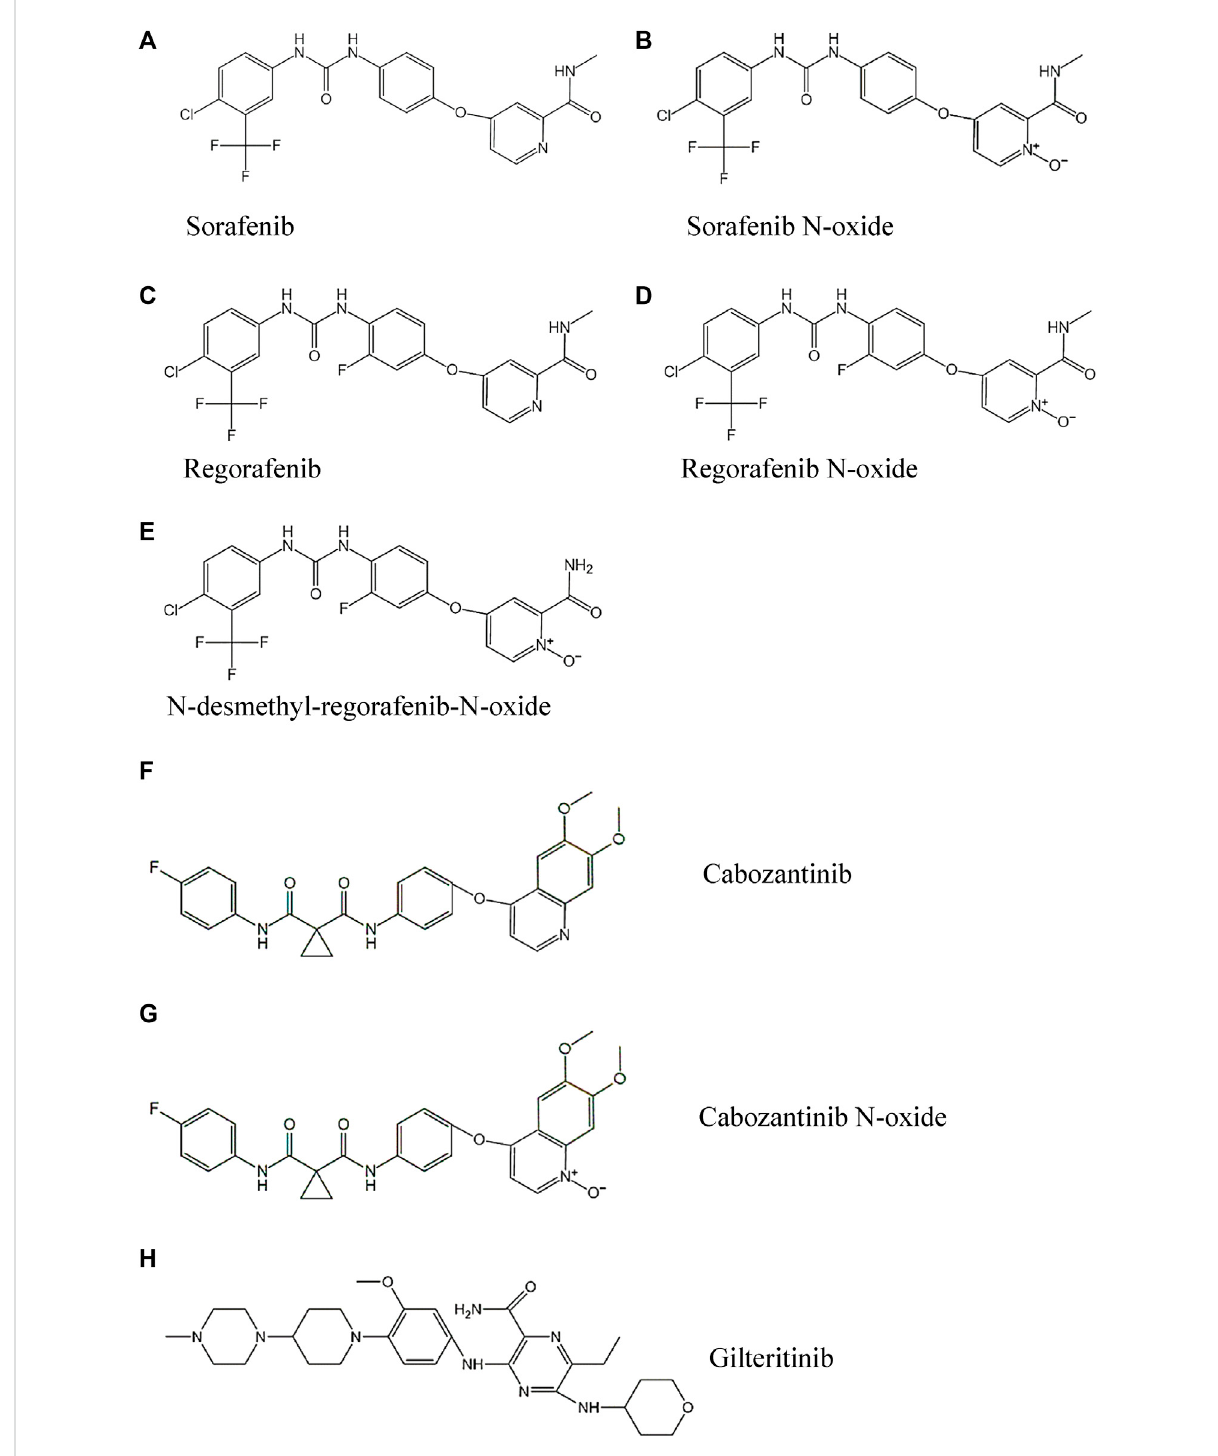
FIGURE 1 The chemical structures of the three TKIs, four active metabolites and IS studied: (A) Sorafenib, (B) Sorafenib N-oxide, (C) Regorafenib, (D) Regorafenib N-oxide, (E) N-desmethyl-regorafenib-N-oxide, (F) Cabozantinib, (G) Cabozantinib N-oxide and (H) Gilteritinib.